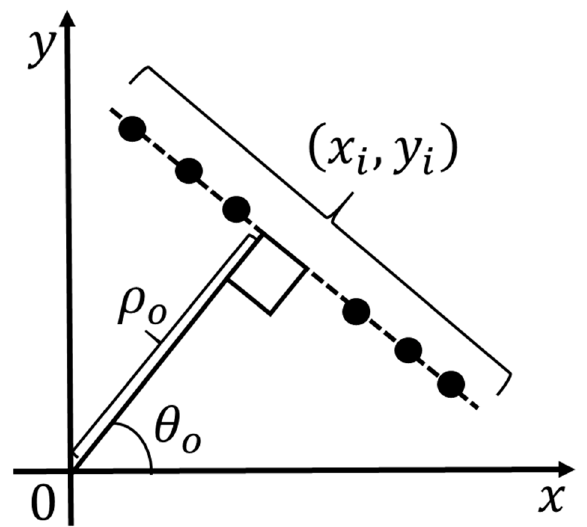
Figure 8. Line in the ( x , y ) space.